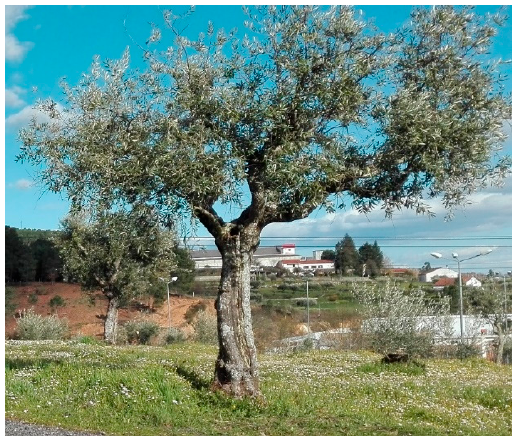
Figure 5. A photograph of the Olea europaea L. tree taken at 5:30 p.m. under direct sunlight. Table 2. Characteristics of sample trees.